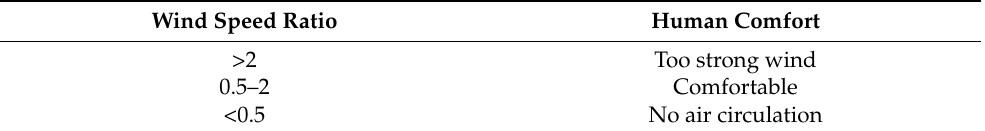
Table 1. The standard of wind speed ratio